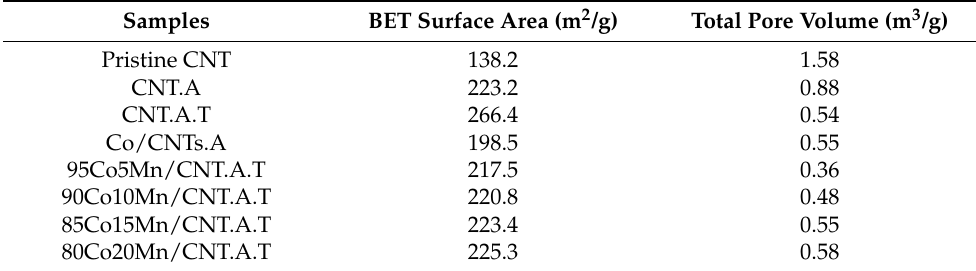
Table 3. Textural properties of Co/CNT catalysts at various wt% loading.